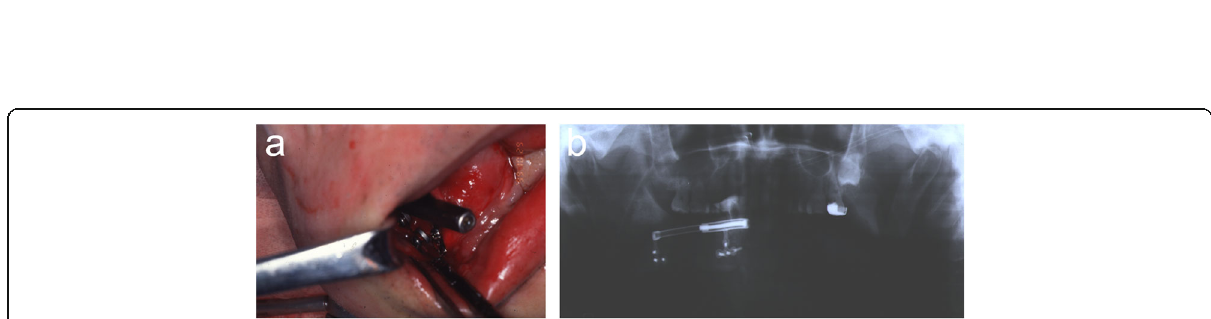
Fig. 2 a Horizontal distraction osteogenesis of the remaining mandible was performed to reduce the bone defect. b Orthopantomogram after horizontal mandibular distraction